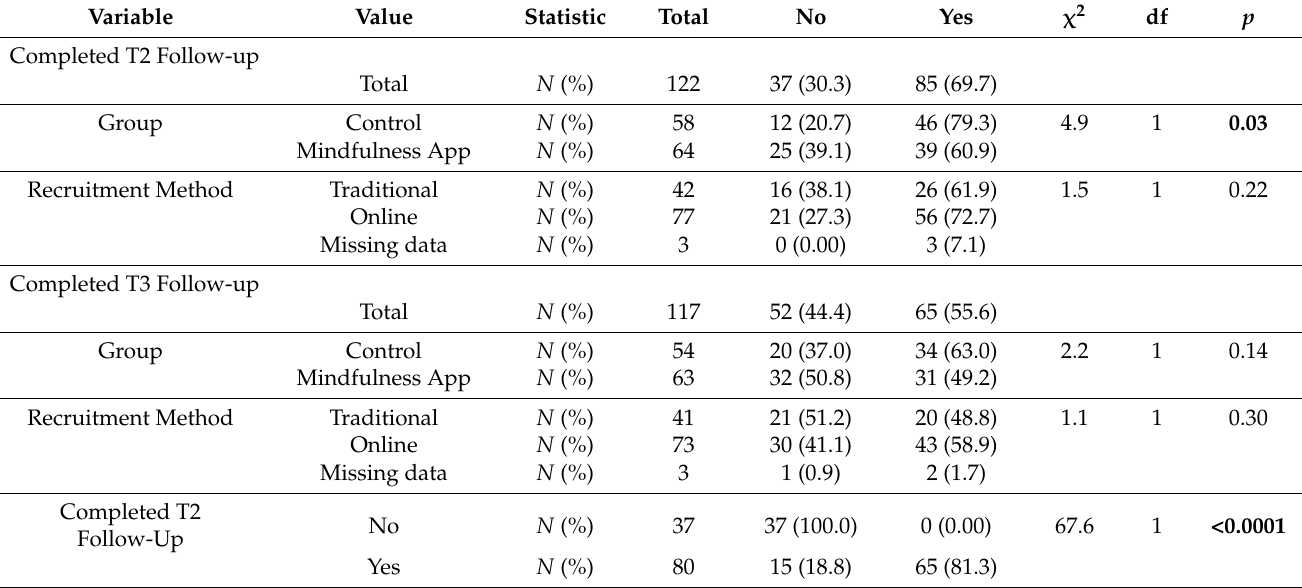
Table 3. Comparing retention rates by recruitment type (one participant missing data for Time 2; six participants missing data for Time